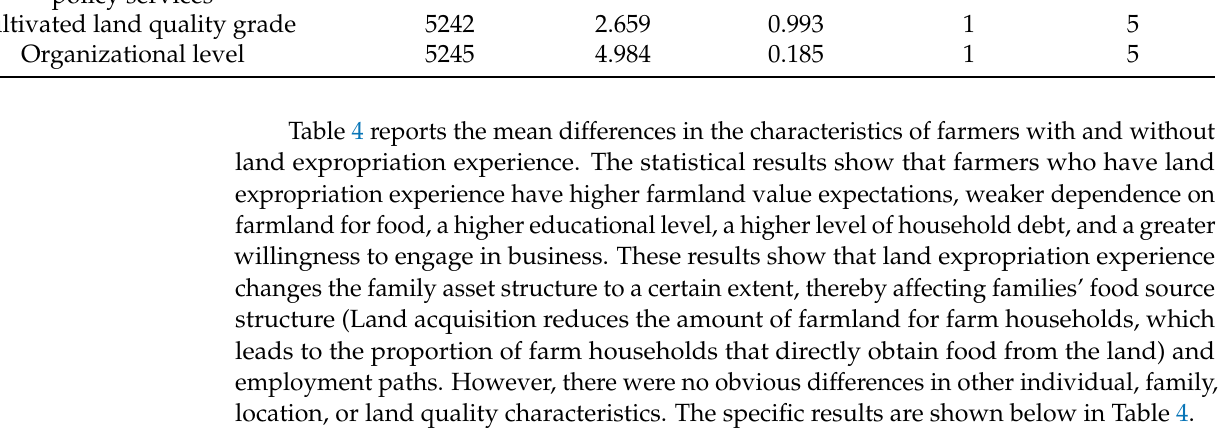
Table 4. Grouped mean T